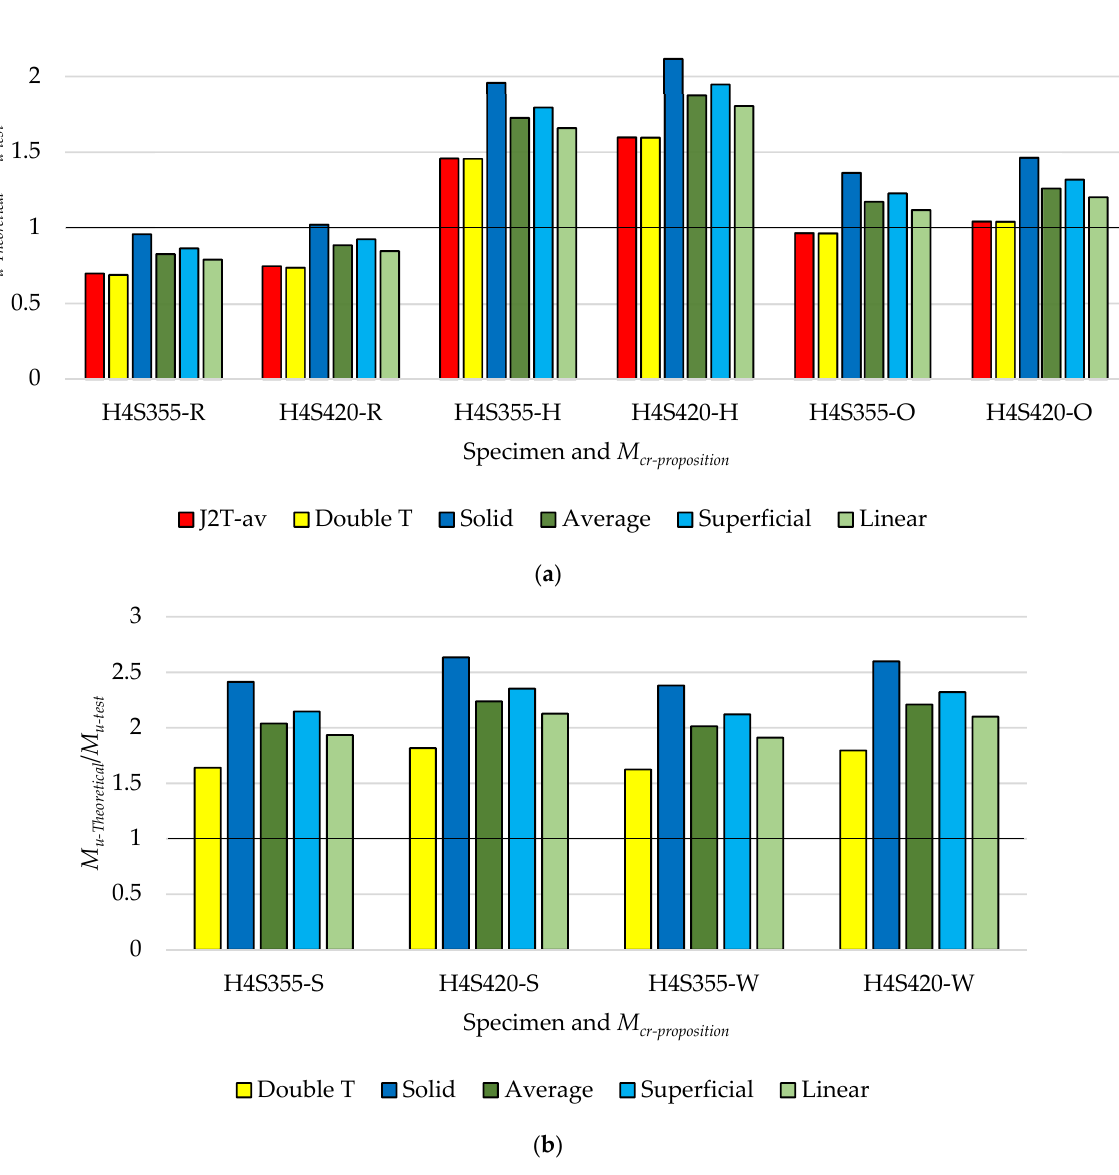
Figure 20. Accuracy obtained by the Salah’s M u proposition [58] for composite cellular beams: ( a ) M cr calculation based on the U-frame model; ( b ) M cr calculation proposed by Svensson [121] and Williams and Jemah [122].